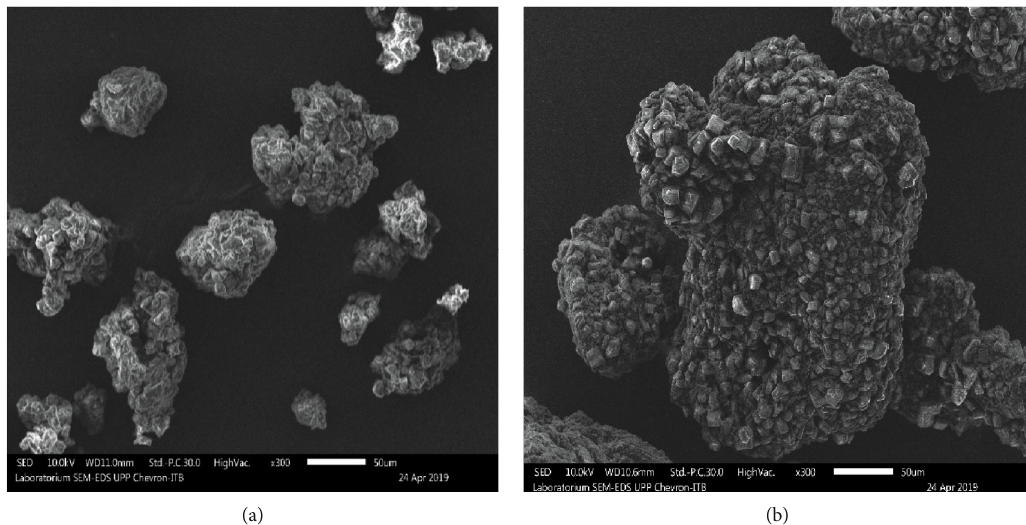
Figure 7: Scanning electron micrographs of conventional coconut sugar powder particles (a) without and (b) with the addition of 1% tricalcium phosphate.